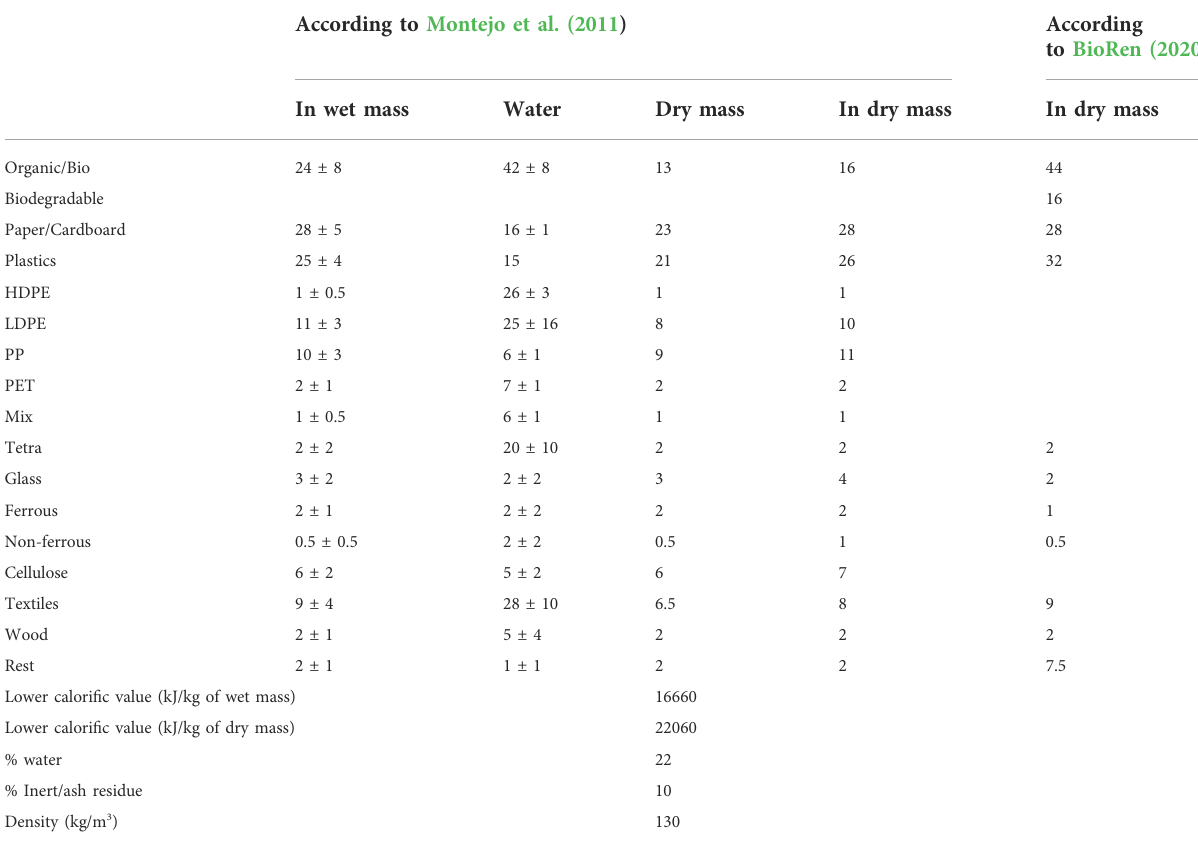
TABLE 1 Composition of refuse-derived fuel obtained in mechanical – biological treatment plants. Component/material Content (%) According to Montejo et al.